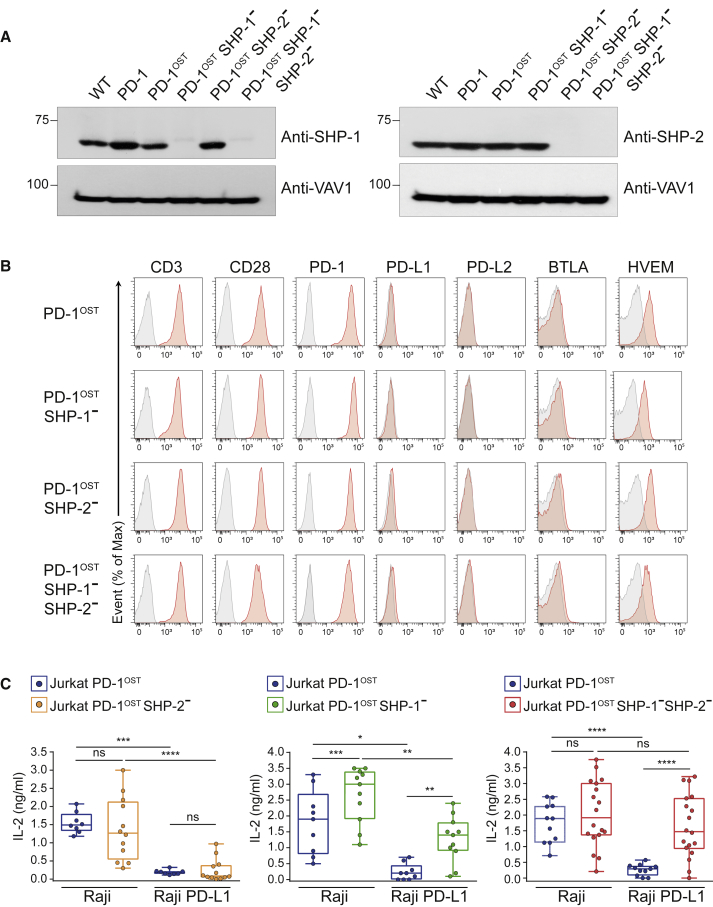
Either SHP-1 or SHP-2 Suffices for PD-1 Coinhibition in Jurkat T Cells(A) Immunoblot analysis of equal amounts of proteins from total lysates of representative clones of WT Jurkat, Jurkat-PD-1, Jurkat-PD-1OST, Jurkat-PD-1OST SHP-1–, Jurkat-PD-1OST SHP-2–, and Jurkat-PD-1OST SHP-1–SHP-2– cells probed with antibodies to SHP-1, SHP-2, or VAV1 (loading control). Left margin, molecular size in kilodaltons. Data are representative of two independent experiments.(B) Jurkat-PD-1OST, Jurkat-PD-1OST SHP-1–, Jurkat-PD-1OST SHP-2–, and Jurkat-PD-1OST SHP-1– SHP-2– cells were analyzed using flow cytometry for expression of CD3, CD28, PD-1, PD-L1, PD-L2, BTLA, and HVEM. Gray shaded curves correspond to isotype-matched control antibody (negative control), and data are representative of two independent experiments.(C) IL-2 production by Jurkat-PD-1OST, Jurkat-PD-1OST SHP-1–, Jurkat-PD-1OST SHP-2–, and Jurkat-PD-1OST SHP-1–SHP-2– clones stimulated with Raji cells or Raji-PD-L1 cells in the presence of 1 ng/mL SEE. Analysis of IL-2 production was performed 24 h after stimulation. Expression of IL-2 (ng/mL) using boxplot with the median, boxed interquartile range, and whiskers extending to the most extreme point up to 1.5 times the interquartile range. Each dot corresponds to a clone of the specified Jurkat cells. ∗p ≤ 0.05, ∗∗p ≤ 0.01, ∗∗∗p ≤ 0.001, and ∗∗∗∗p ≤ 0.0001; ns, non-significant (unpaired Student’s t test). Data are representative of two independent experiments.